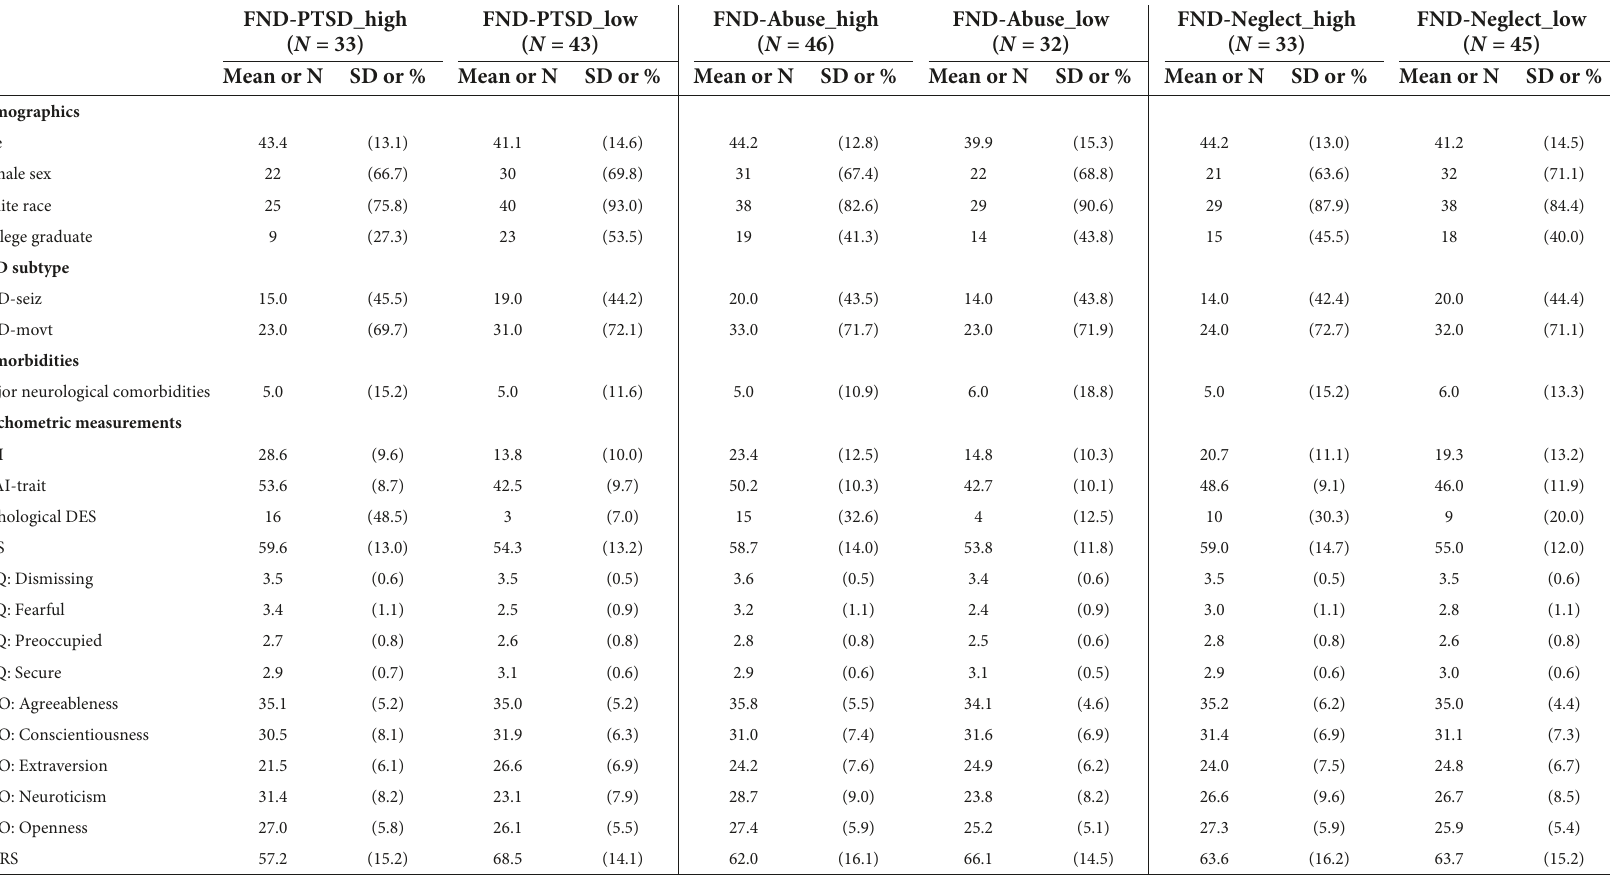
TABLE 1 Demographic and clinical characteristics of stratified functional neurological disorder